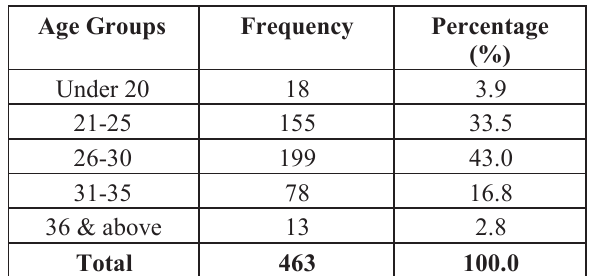
Table-1: Age Groups of the Patients HBsAg